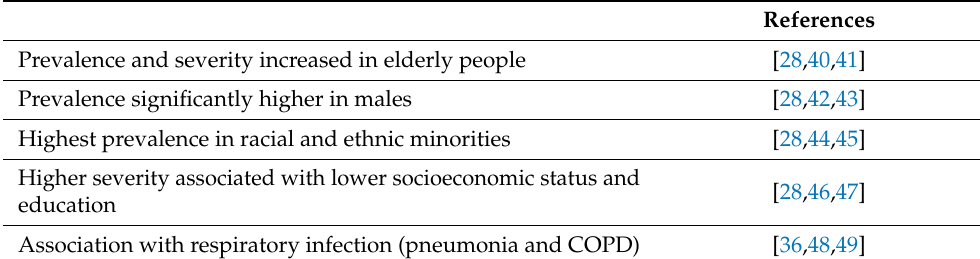
Table 1. Characteristics of periodontal